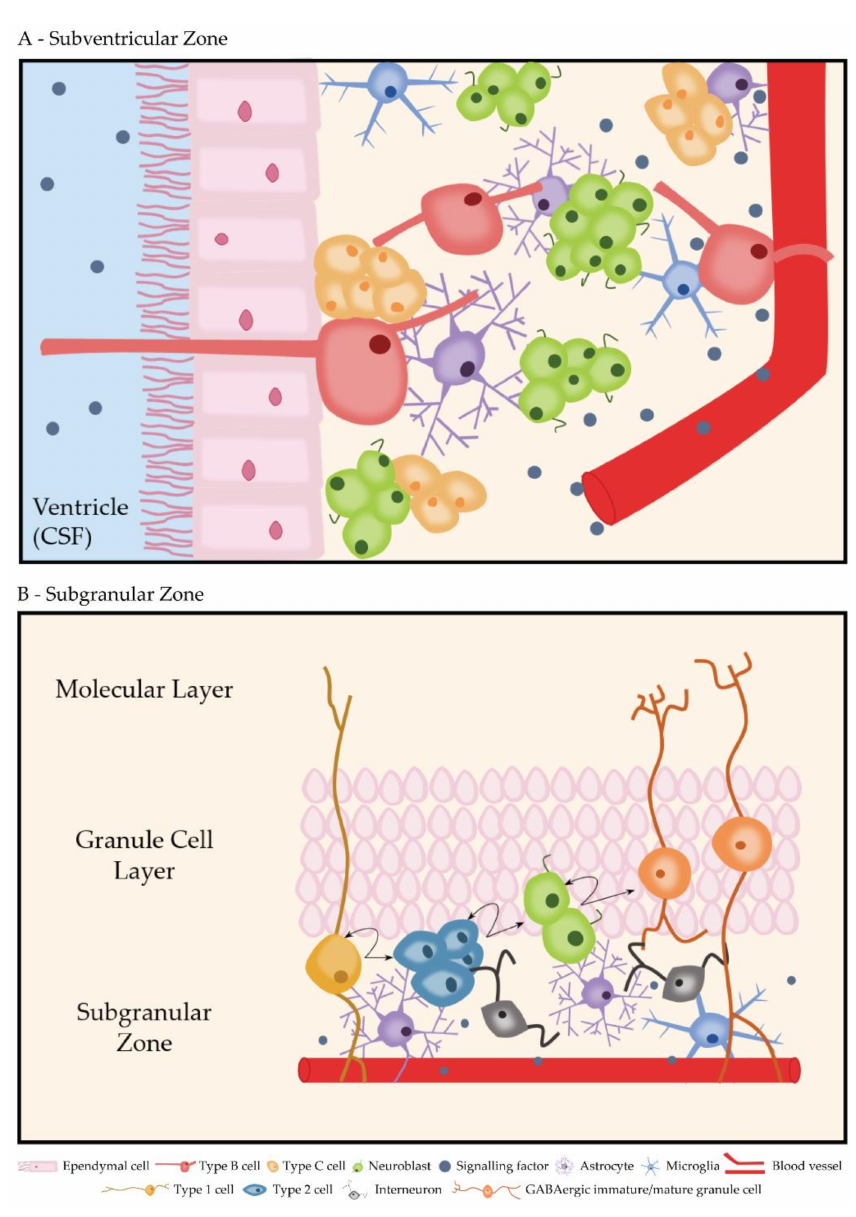
Figure 3. The neurogenic niches. ( A ) Cytoarchitecture of the Subventricular Zone. Type B cells extend cellular processes to the ventricle where they come into contact with cerebralspinal fluid (CSF) and to nearby blood vessels, detecting intrinsic and extrinsic factors that will signal for proliferation and/or differentiation. B cells differentiate into C cells, which generate neuroblasts. Astrocytes and microglia are also found in the neurogenic niche and support the stem cell pool and the development of newborn cells. ( B ) Cytoarchitecture of the Subgranular Zone. The dentate gyrus (DG) is composed of three layers: the molecular layer; the granule cell layer, which are densely packed granule cells; and the subgranular zone, containing neural stem and progenitor cells. Here, type 1 cells extend cellular processes to the molecular layer and can generate intermediate progenitor cells, or type 2 cells, which are closely associated with the hippocampal vasculature and the detection of signaling factors. Neuroblasts differentiate from type 2 cells and into GABAergic dentate granule cells. These mature by making functional connections with CA3 hippocampal cells, whilst migrating towards the molecular layer of the DG. Interneurons, microglia and astrocytes contribute to the maintenance and support of the